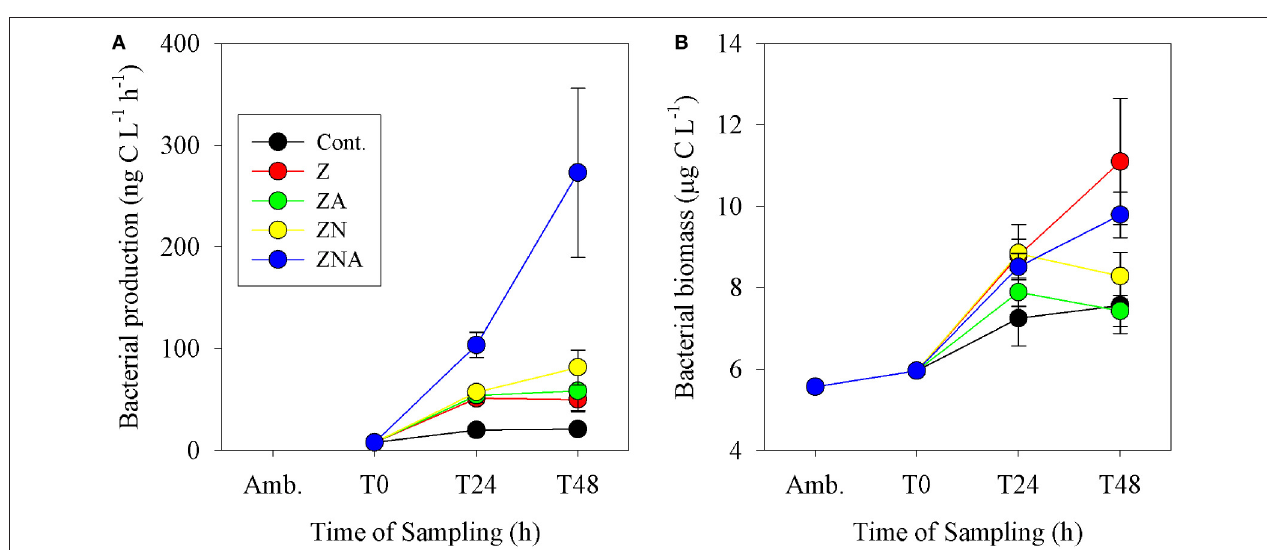
FIGURE 4 | Measured changes in (A) bacterial activity rate and (B) calculated bacterial biomass in the microcosm treatments compared with the initial ambient values of the water used to inoculate the microcosm bottles.